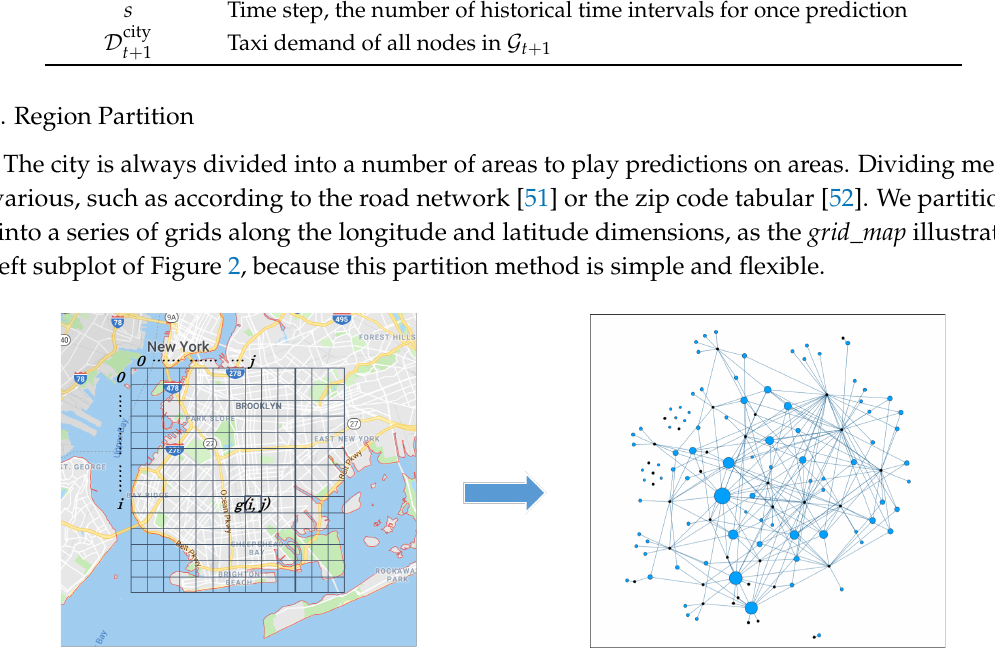
Figure 2. Illustration of the region partitioning on a city and the transformed city graph. We use Brooklyn, New York as an example, in which the grid map is obtained after the city being divided along the longitude and latitude, like the left subplot. Afterwards, the grid map is converted into a city graph with grids as nodes and OD relations as edges, like the right